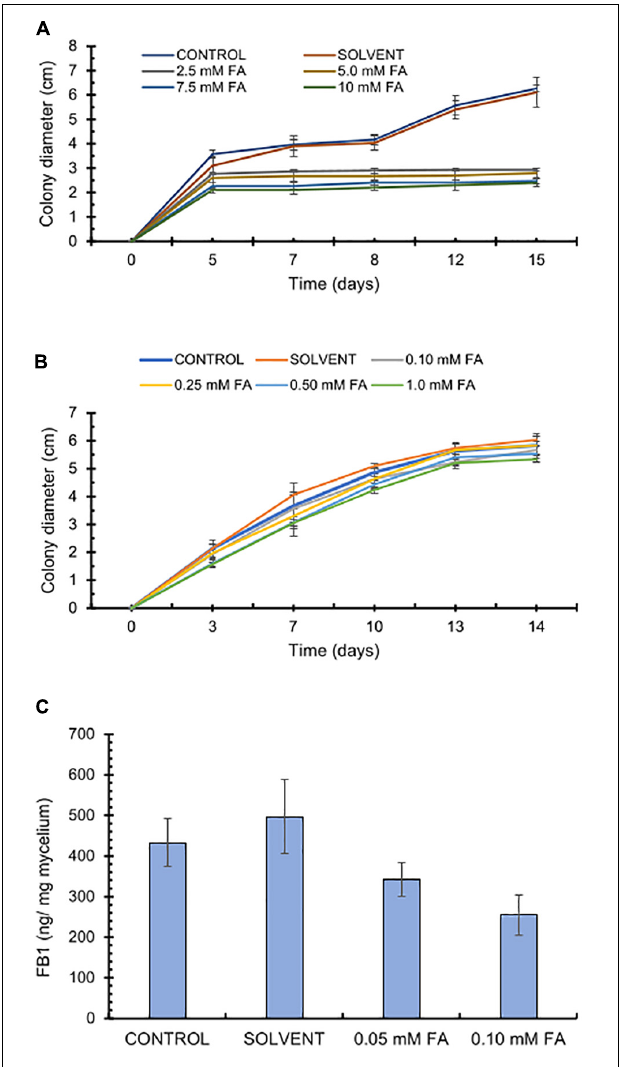
FIGURE 2 | Effect of ferulic acid concentrations on F. verticillioides radial growth and fumonisin production. (A) Effects of high ferulic acid (FA) concentrations on fungal radial growth. 2 × 10 3 conidia were inoculated in the center of PDA plates containing FA (2.5, 5, 7.5, or 10 mM). (B) Effects of low ferulic acid concentrations on fungal radial growth. 2 × 10 3 conidia were inoculated in the center of PDA plates containing FA (0.1, 0.25, 0.5, or 1.0 mM). (C) Effect of ferulic acid on FB1 production. 1.25 × 10 5 F. verticillioides conidia were inoculated in GYAM medium containing 0.05 or 0.1 mM FA. FB1 levels were analyzed 12 days post-inoculation by HPLC of the OPA fluorescent derivatives; values are means ± SD, and